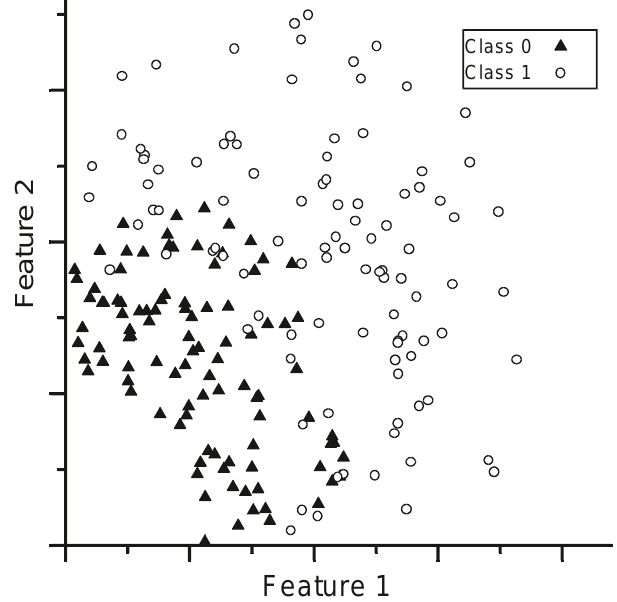
Fig. 4. Training data for a simple classification problem. The points are randomly selected from two slightly overlapping annular probability distributions. nearly identical features from different classes. We randomly generate 200 points, 100 from each class, as the training data. A test set of 1000 points is generated to test the performance of classifiers designed with the training data. It consists of 500 points from each class drawn from the respective probability